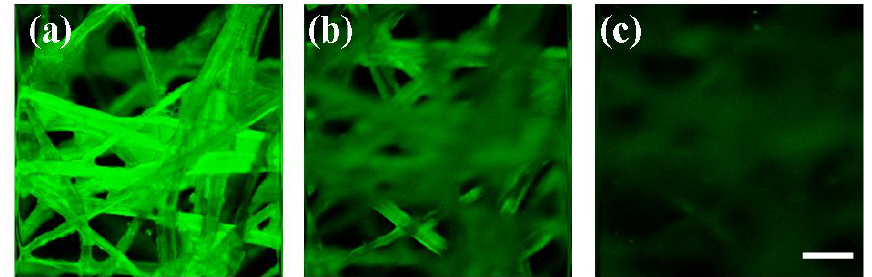
Figure 2. TPEF images recorded at different depth locations (0 ( a ), 40 ( b ), and 100 ( c ) μ m). Samples correspond to a piece of cellulose stained with DAPI (4 ′ ,6-diamidino-2-phenylindole). Bar length: 50 μ m. The reduction in TPEF signal between ( a ) and ( c ) was 83%. This decrease in the image quality as a function of depth can be minimized by com- pensating for the SA value corresponding to each particular depth location. The effect of the SA on TPEF images from the same piece of cellulose is presented in Figure 3a. The imaged plane within the sample was randomly chosen (100 µ m for this case). Different amounts of SA were introduced by the SLM during image acquisition. There is a particular SA value providing an image with a maximum signal. For these images, there was an improvement in the signal of 41%. As expected, this optimum value was unique for each sample and depth location.